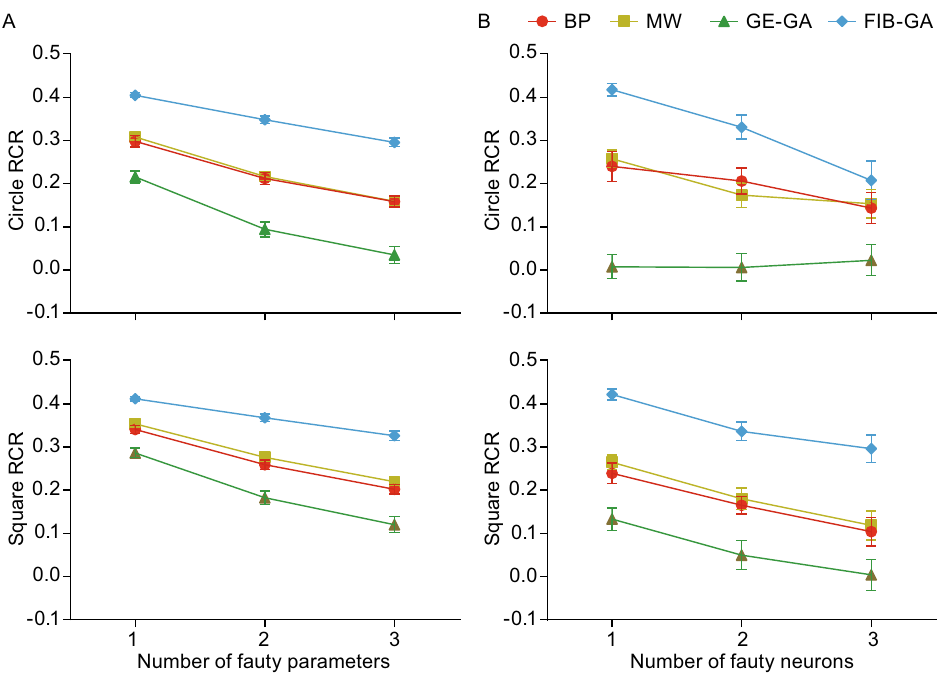
Figure 5. Relative correct rates of different ANNs with six hidden-layer neurons in solving an overlapping classi fi cation problem. (A) The plot of circle RCR (top) and square RCR (bottom) versus the number of faulty parameters. (B) The plot of circle RCR (top) and square RCR (bottom) versus the number of